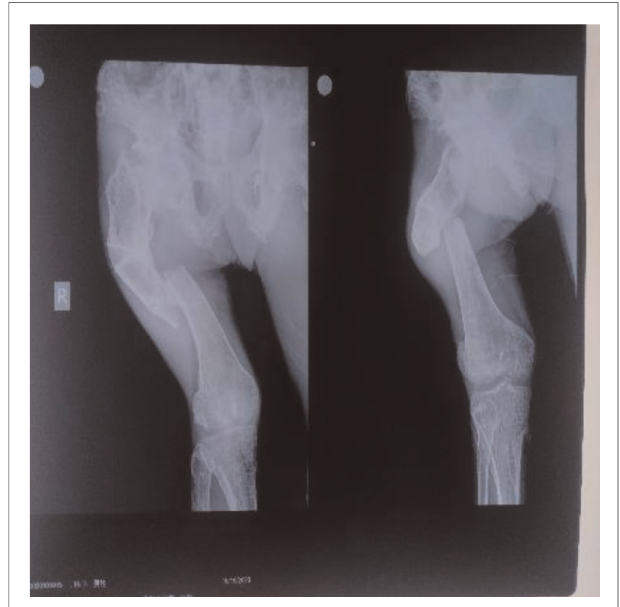
FIGURE 1 | X-ray of the patient on